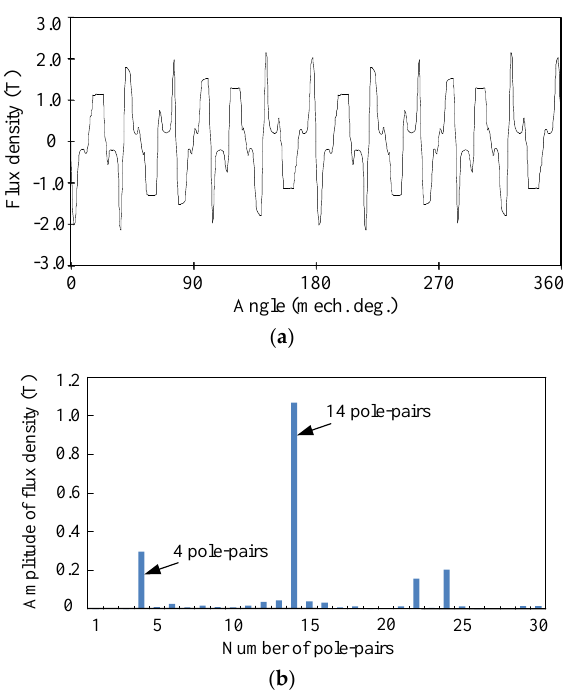
Figure 3. No-load air-gap flux density of the proposed 18-slot/8-pole FMPM machine. ( a ) Waveform; and ( b ) harmonic spectrum.